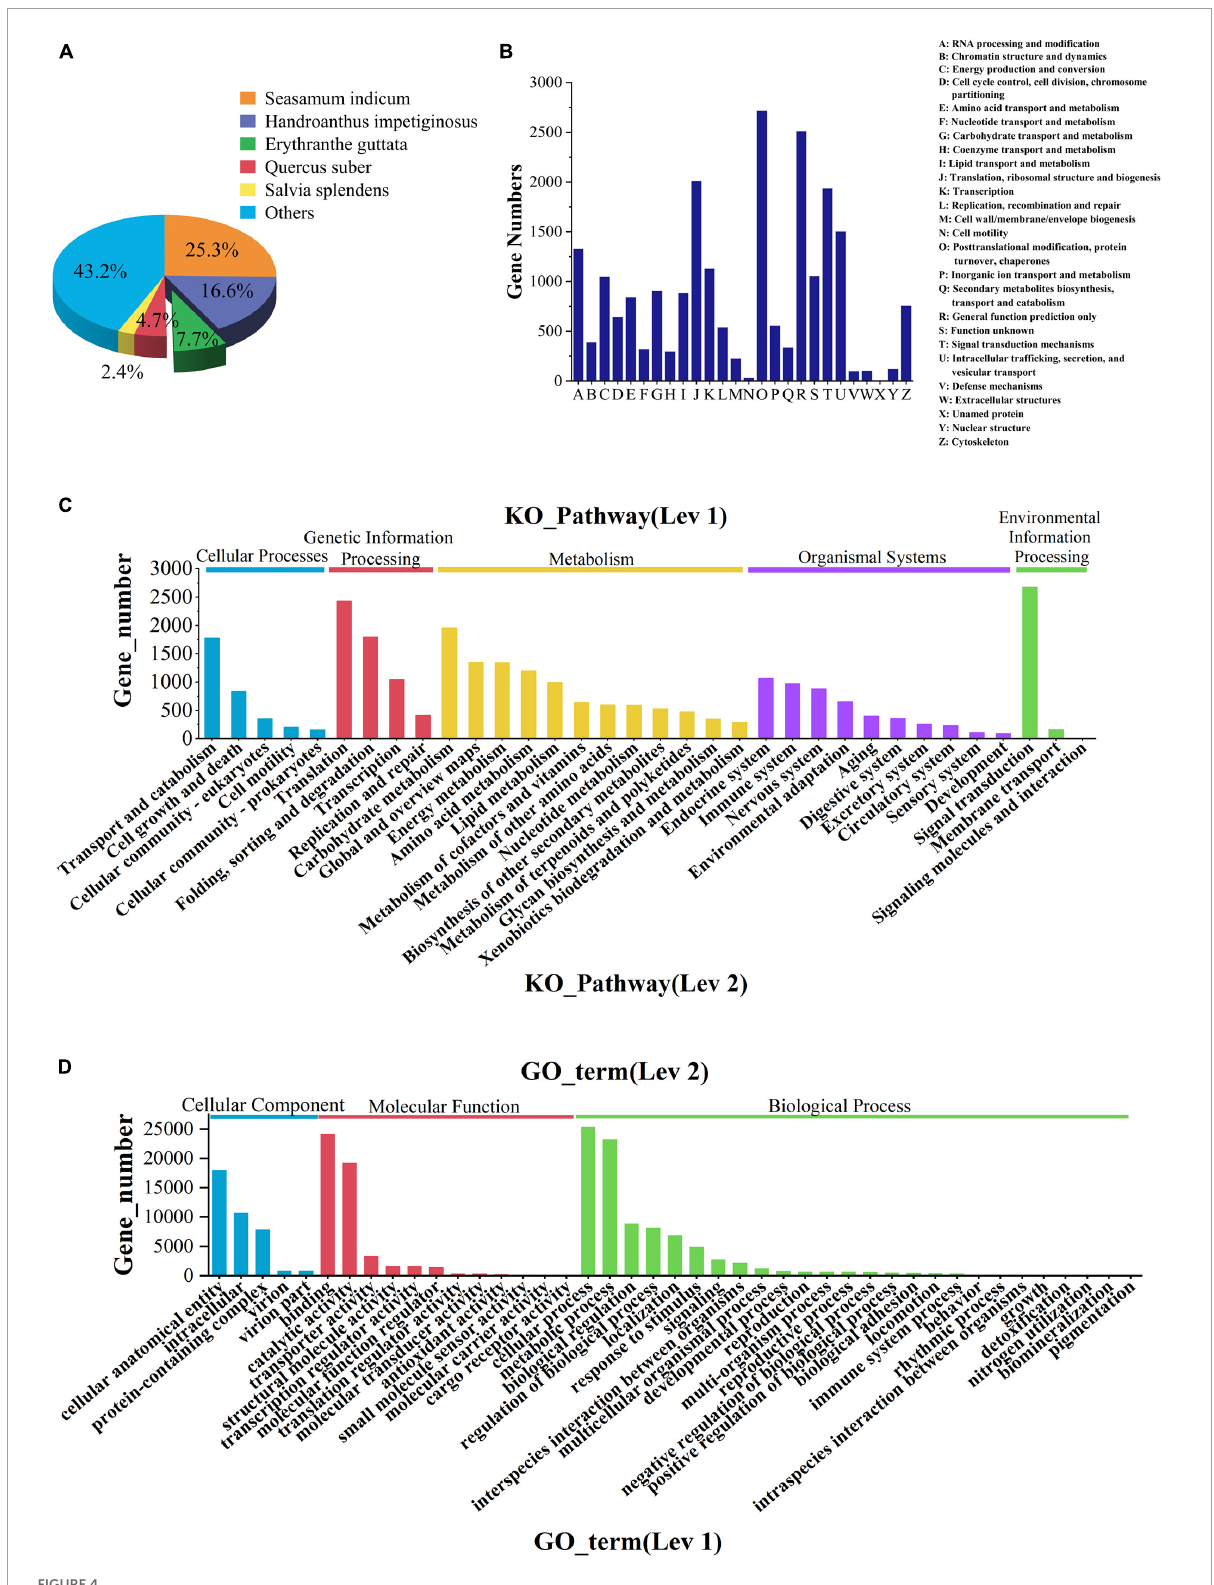
FIGURE4 Database annotation classification. (A) Species distribution of transcriptomic unigenes against NR database. (B) KOG classification. (C) KEGG pathway classification. (D) GO